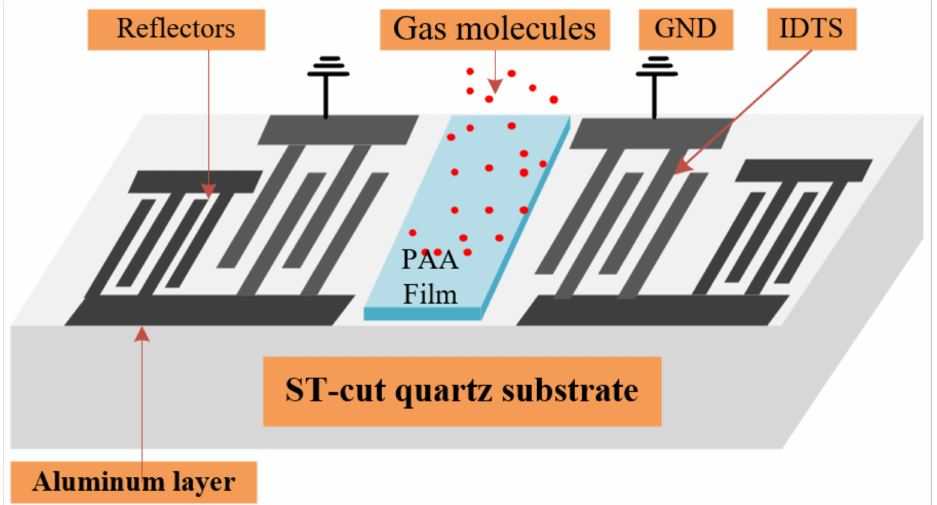
Figure 1. Schematic illustration of the SAW